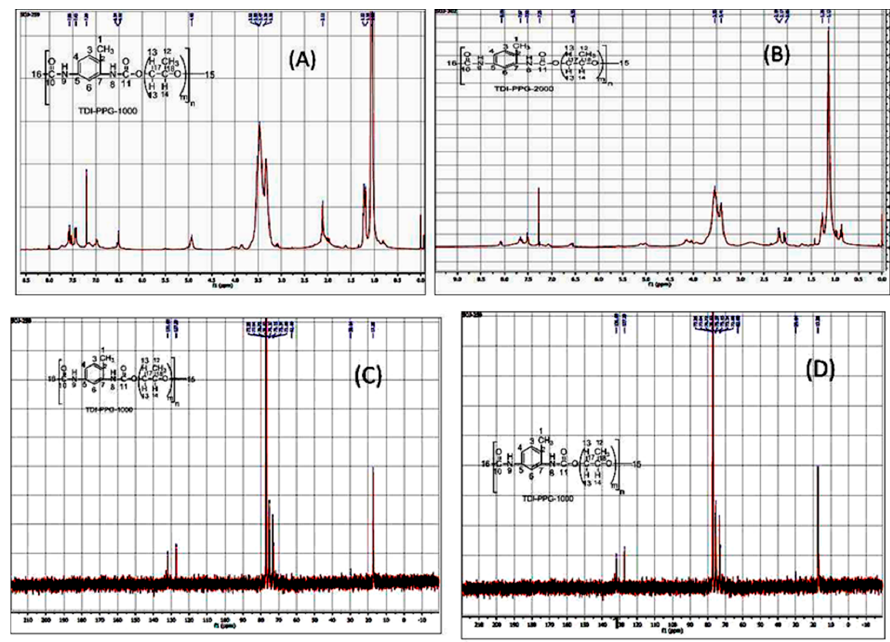
Figure 2. ( A ) 1 H NMR spectrum of TDI-PPG-1000, ( B ) 1 H NMR spectrum of TDI-PPG-2000, ( C ) 13 C NMR spectrum of TDI-PEG-400 and ( D ) 13 C NMR spectrum of